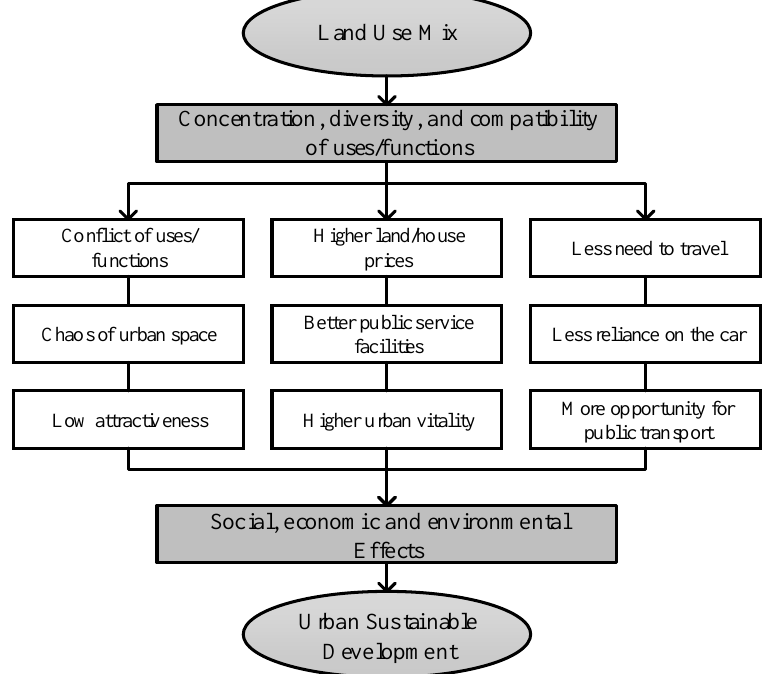
Figure 3. Effects of land use mix (adapted from: [15]).